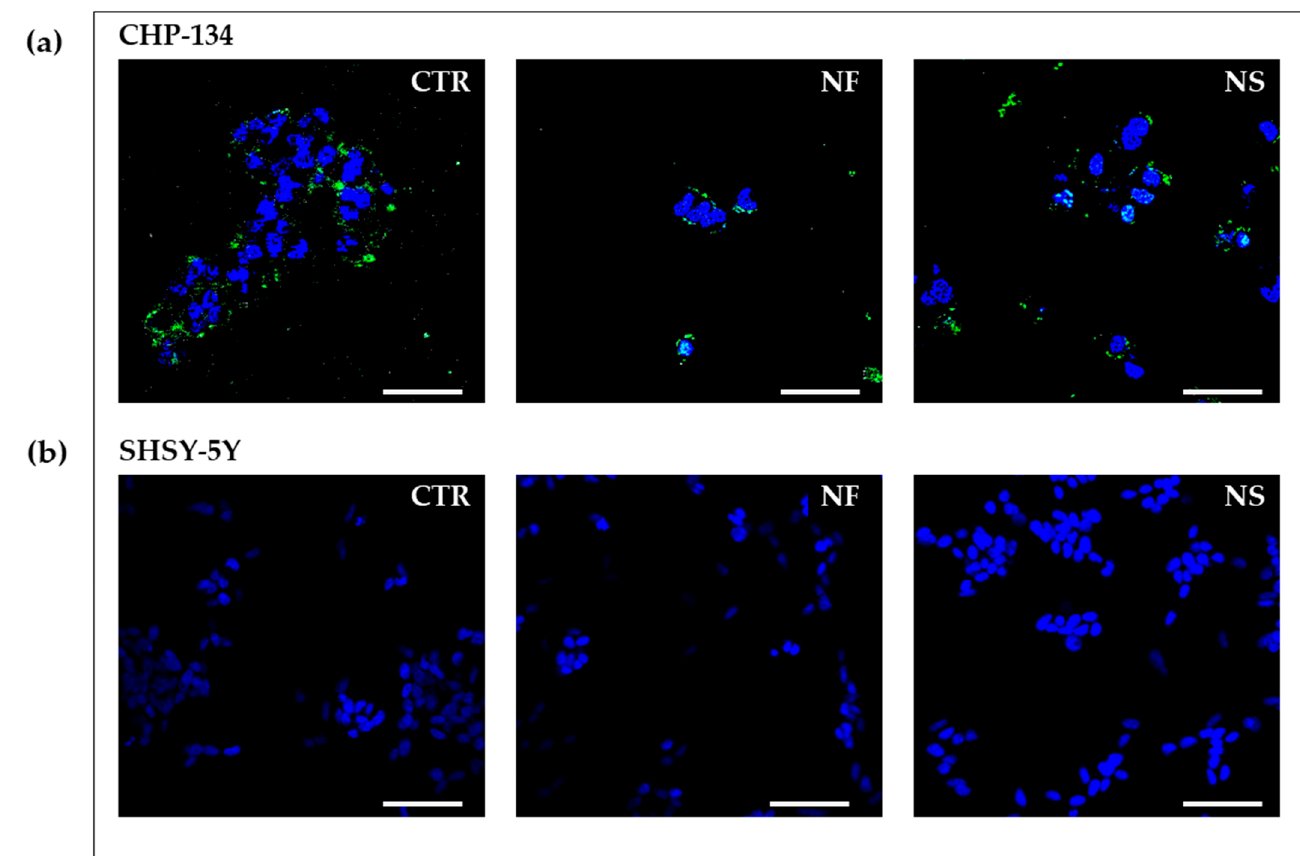
Figure 9 . Confocal microscopy of ( a ) CHP-134 cells and ( b ) SH-SY5Y cells treated with NF or NS at 0.05 mg/mL for 24 h and subsequently exposed for 1 h to 20 µg/mL naxitamab-fluorescein conjugate (NX-F). Photographs were taken at 40X magnification, bar = 10 µm.